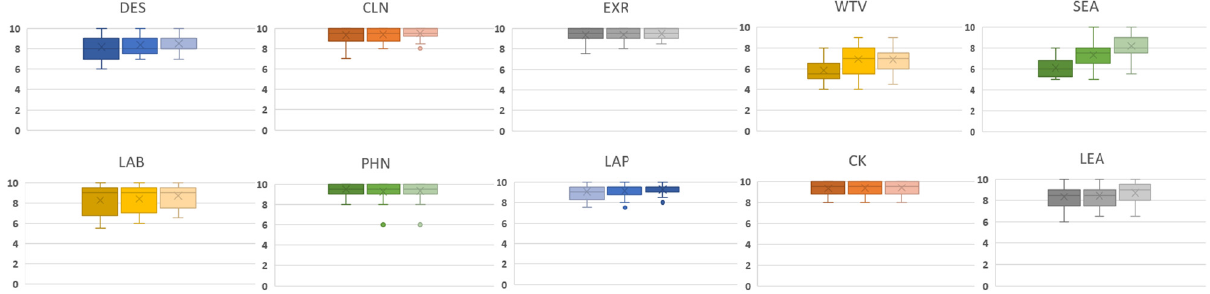
Figure 9: This graph shows the mean values of feedback scores received from users for the acceptance of robot ’ s behavior in the three occasions: initial stage, after 7 days of initial stage, and after 14 days of initial stage. The error bars represent the minimum and maximum scores received.